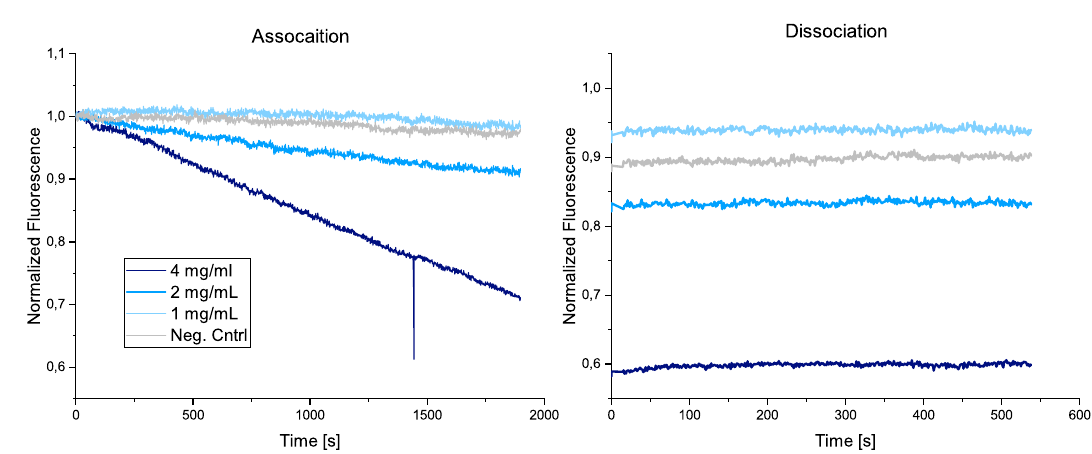
Figure 5. Pseudo virus—peptide interaction. Lenti-virus based pseudo viruses that carry the SARS-CoV-2 spike protein on their surface were injected and their binding to the DNA nanostructures with three SBP1 peptides was observed. Here as well, concentration dependent linear signal changes in the fluorescence intensity upon injection can be observed in the course of the